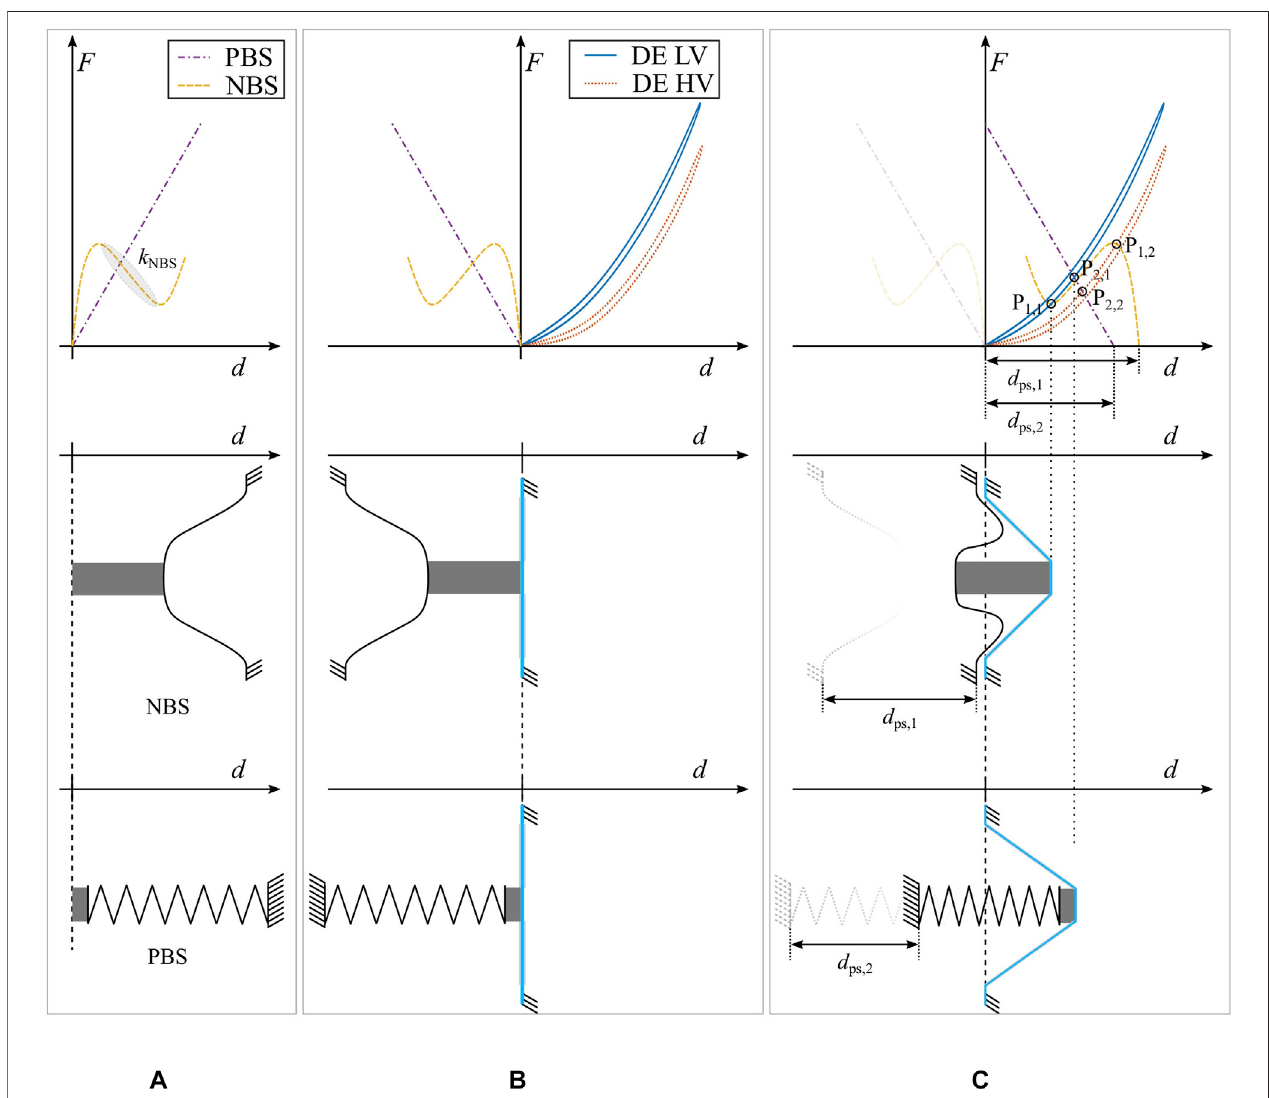
FIGURE3| Schematic depictionofthebiasedDEA. (A) showstheforce-displacement curves ofaPBSandaNBSinthe fi rst row.Inthelowerpart, asketchofthe two considered biasing elements is depicted. (B) shows the resulting system curves and a sketch of the assembly, when a COP-DEA is brought into contact with the biasing elements. (C) represents the system force-displacement curves in the biased state, and shows the resulting con fi guration in each one of the two sketched assemblies.